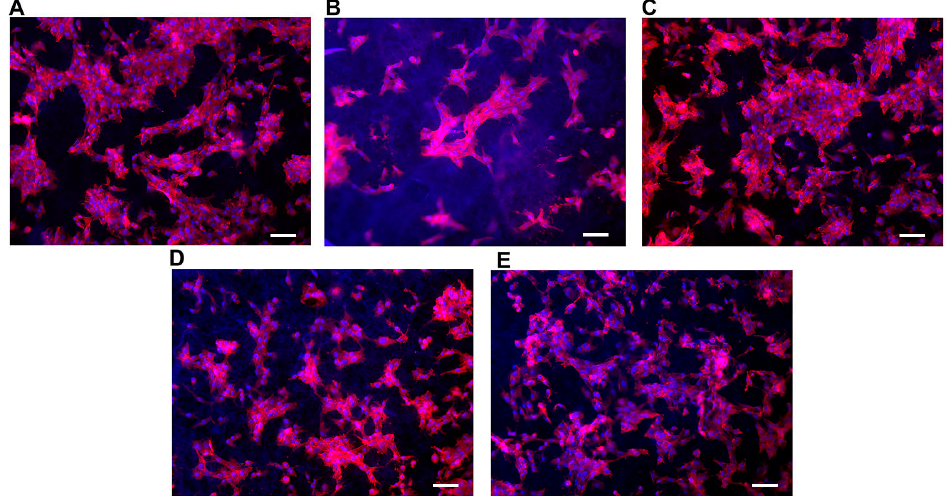
Figure 6. Representative images of C2C12 cells on the different types of scaffolds showing F-actin (red) into cytoplasm and nuclei stained with DAPI (Blue). Scale bars = 30 μ m for ( A – E ).